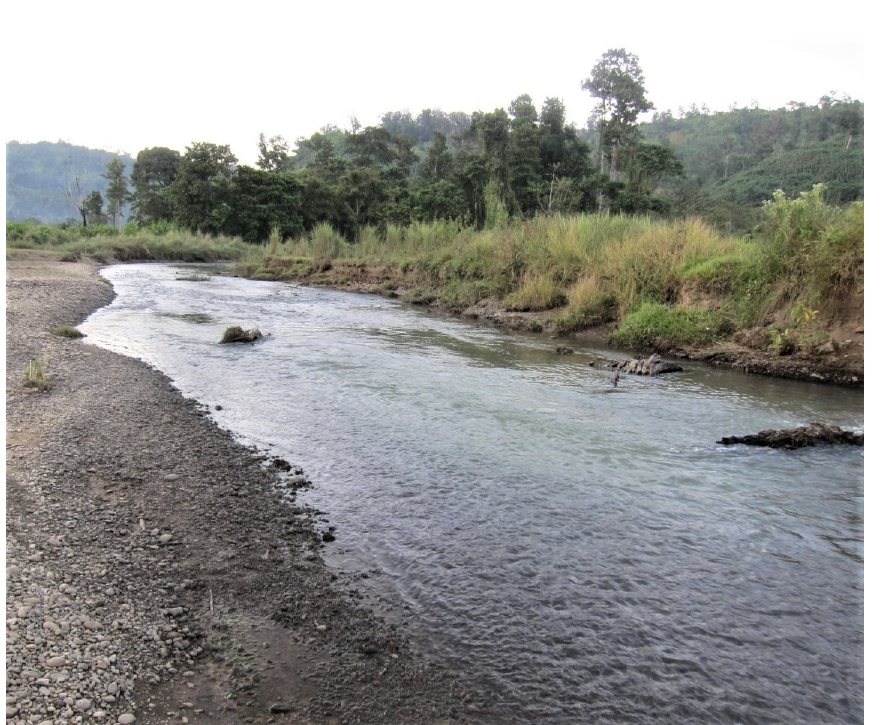
Fig 5. Type locality of Badis kaladanensis (Palak River, Mizoram, India).